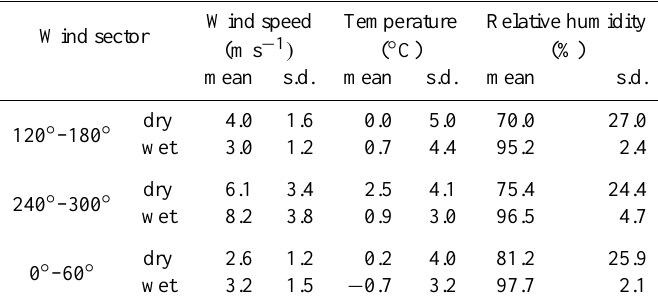
Table 1. Means and standard deviation (s.d.) of meteorological parameters for the three main wind sectors during dry (no precipitation) and wet (precipitation > 0) conditions.